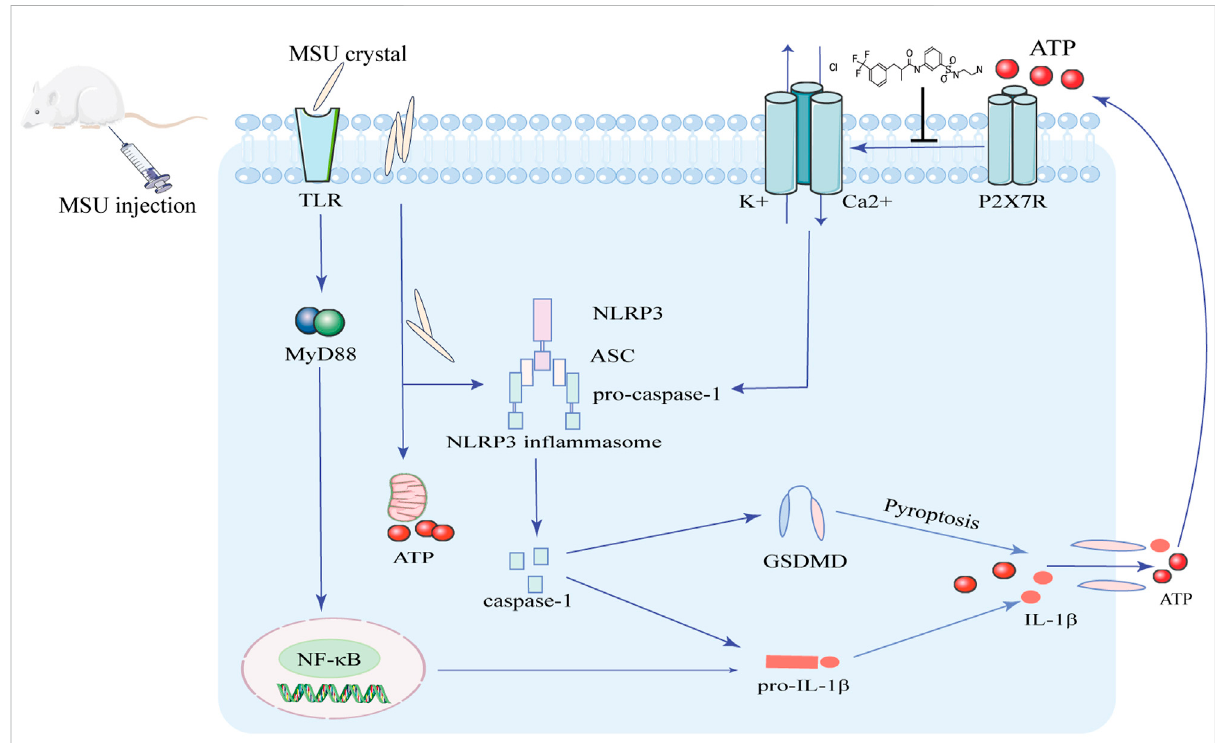
FIGURE. 11 Schematic diagram of the mechanism of Z1456467176 in the treatment of MSU crystal-induced acute gouty arthritis. MSU crystal stimulation promotes ATP production, which is released through caspase-1-dependent pyroptosis. The interaction of extracellular ATP with P2X7R alters the structure of the protein and induces ion fl ow. Together with MSU crystals, it activates the NLRP3 in fl ammasome and promotes the release of suf fi cient IL-1 β to trigger the gout in fl ammatory response. Z1456467176 inhibits ATP-induced channel opening and P2X7R-NLPR3-IL-1 β pathway activation by remodeling the structure of P2X7R protein. Thus, acute gouty arthritis induced by MSU crystals was